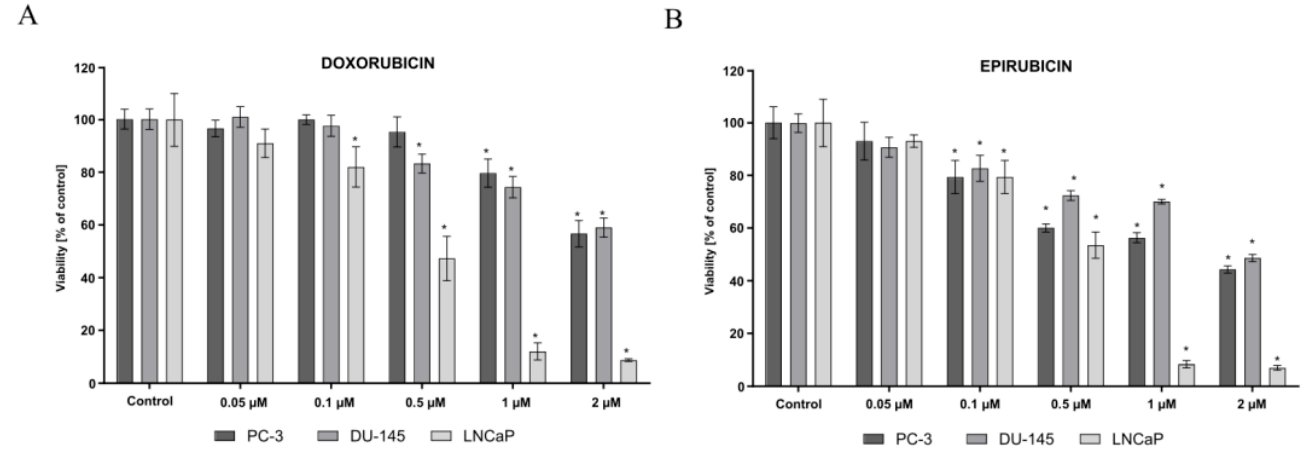
Figure 2. Prostate cancer cell lines (PC-3, DU-145, LNCaP) viability (% of control) based on MTT assay. The cells were treated with a wide range of ( A ) doxorubicin (0.05–2 µM) ( B ) epirubicin (0.05–2 µM) concentrations for 48 h. The values obtained from three independent experiments were presented as mean ± SD. * p < 0.05 vs. control.